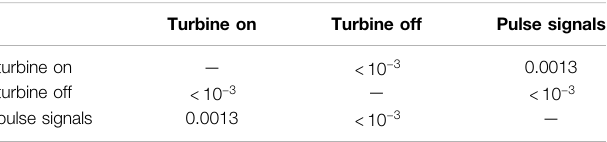
TABLE 2 | Results of Dunn post-hoc test in the form of p-value table. Assuming the level of signi fi cance α (cid:1) 0 . 05 level, the differences between all cases were found to be statistically signi fi